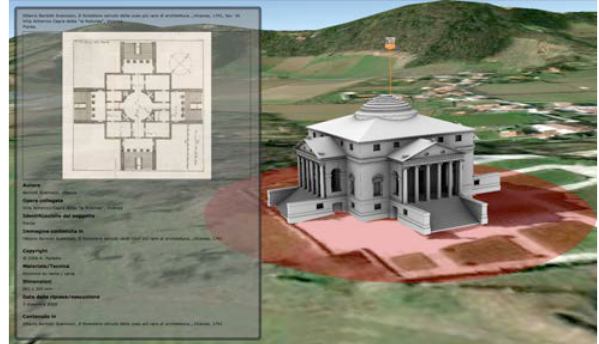
Figure 1. Andrea Palladio - 3D Geodatabase : interface with descriptive card of a historic